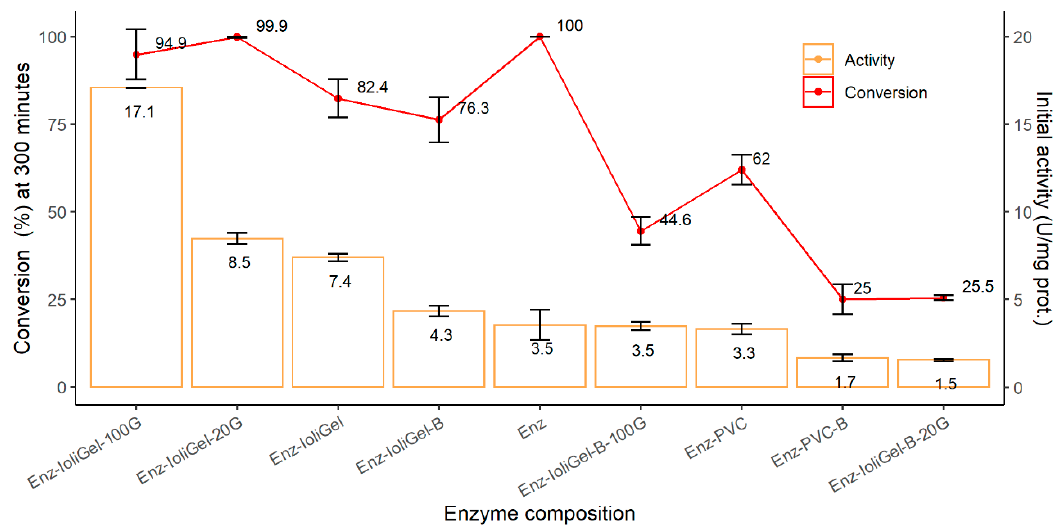
Figure 4. Activity and conversion exhibited by CaLB for butyl butyrate synthesis for different immobilized CaLB and free enzyme at 30 °C.